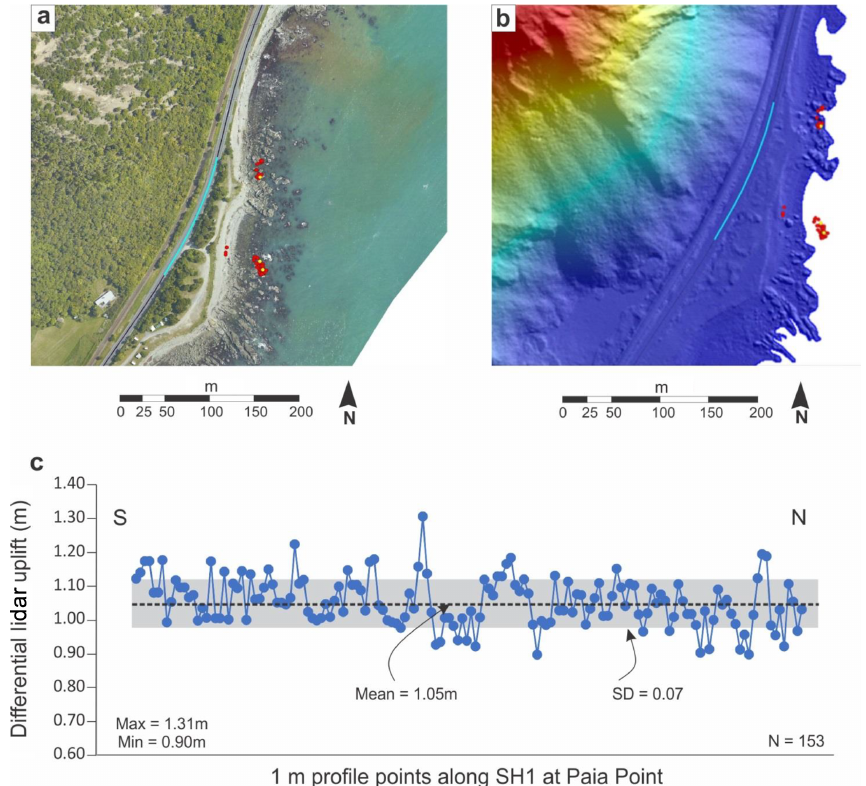
Figure 7. Locality, digital elevation imagery and differential lidar data for Paia Point (see Fig. 1 for location). (a) Aerial photo from Google Earth© imagery of Paia Point, State Highway 1 and uplift collection points. Blue line: portion of SH1 from which differential lidar uplift was calculated; red circles: RTK-GPS-collected kelp data points; yellow circles: tape-measure-collected kelp data points. (b) Digital elevation model developed from post-earthquake lidar data. Blue line and colour-coded circles as per (a) . (c) Plot of uplift of points at 1m intervals along the blue line on SH1 in (a) and (b) derived from differential